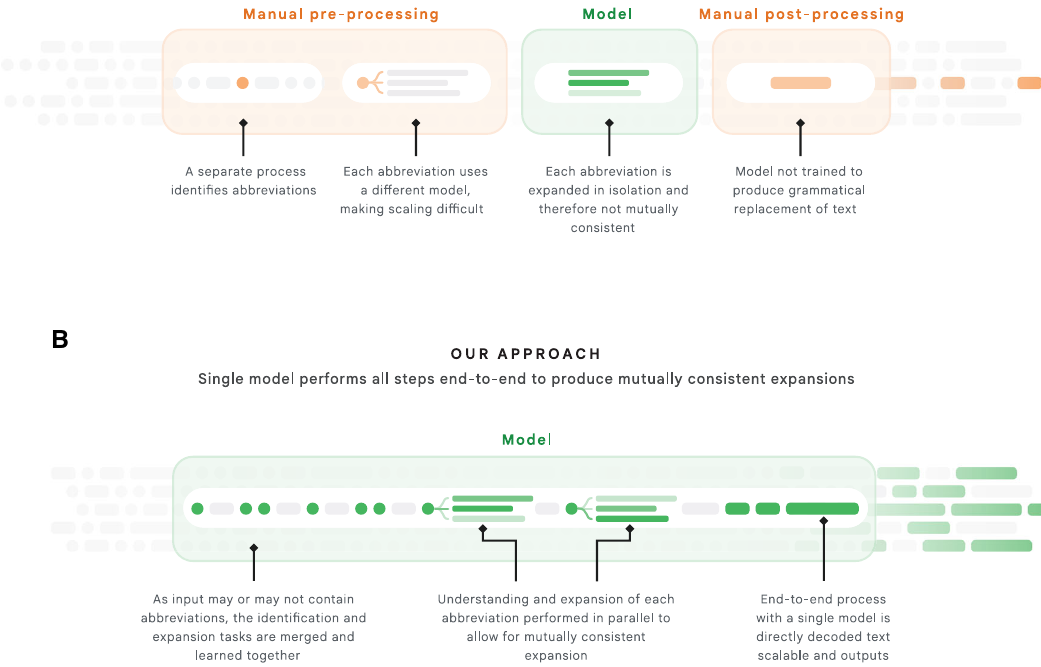
Fig. 1 | Overview of task formulation and comparison against traditional approaches. A Task formulation : The input to our model is a string that may or may not contain medical abbreviations. We trained a model to output a corre- sponding string in which all abbreviations are simultaneously detected and expanded. If the input string does not contain an abbreviation, the model will outputtheoriginalstring. B Traditionalvs.ourapproach